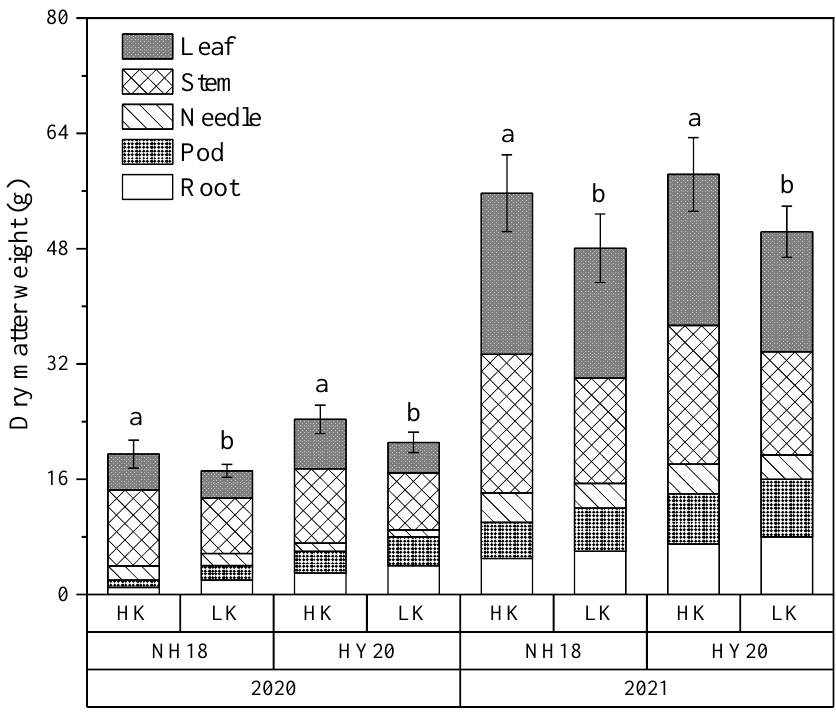
Figure 1. Effects of low K stress on dry matter accumulation of peanuts at maturity. HK: high K treatment; LK: low K treatment. For the bar chart, a,b indicates a significant difference between different treatments for the same variety ( p < 0.05). Table 3. Effects of low K stress on chlorophyll content in